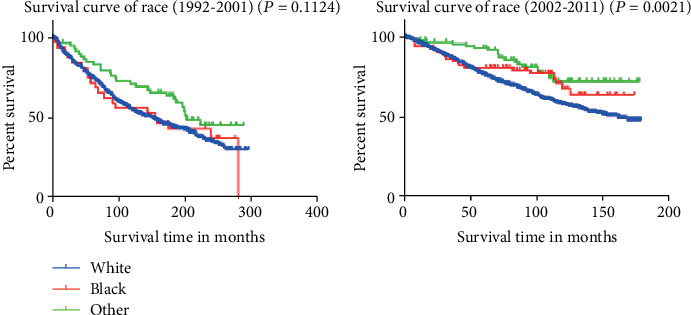
Kaplan-Meier estimate of overall survival as a function of ethnicity in the 1992-2001 and 2002-2011 patient cohorts.